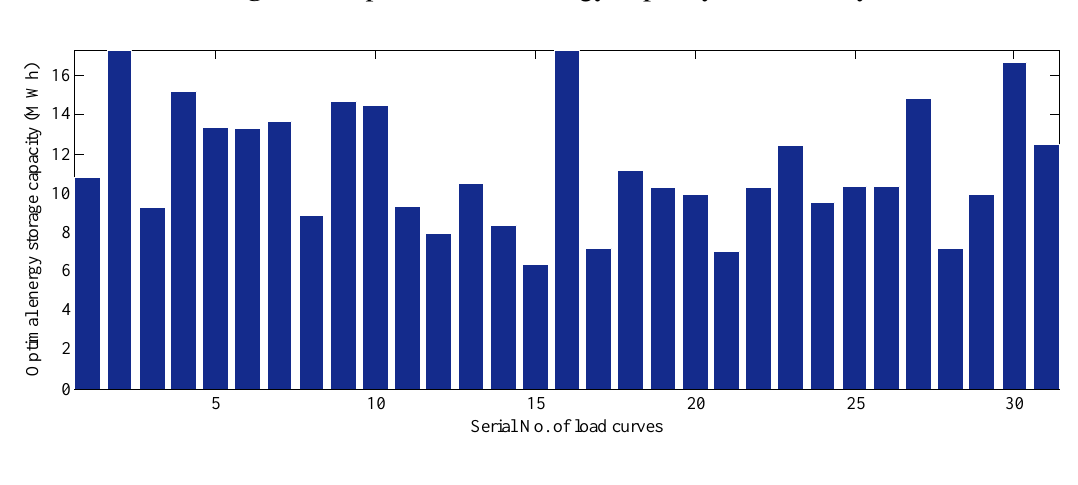
Figure 3. Optimal BESS energy capacity for each day.